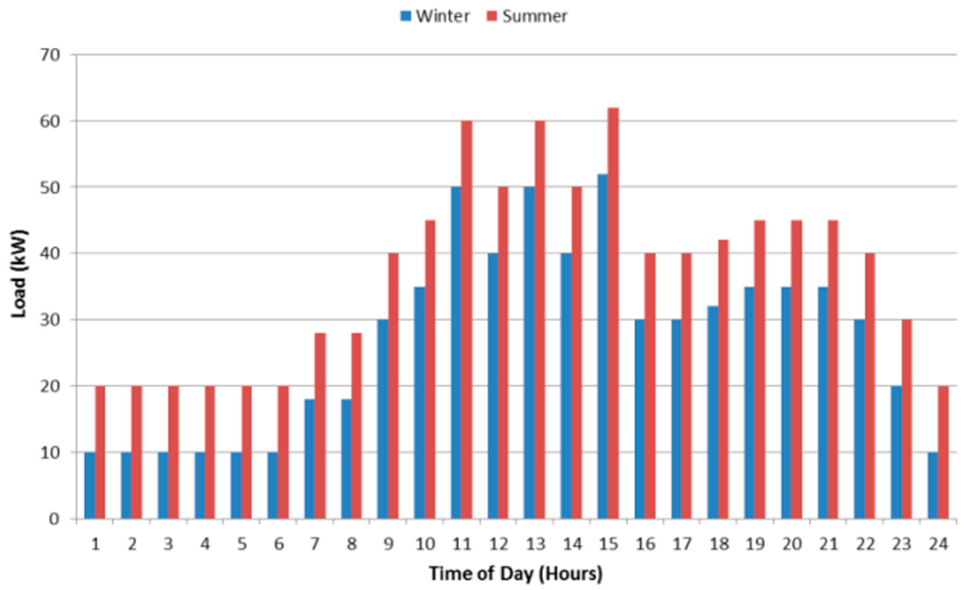
Figure 3. Typical load curve of primary load.